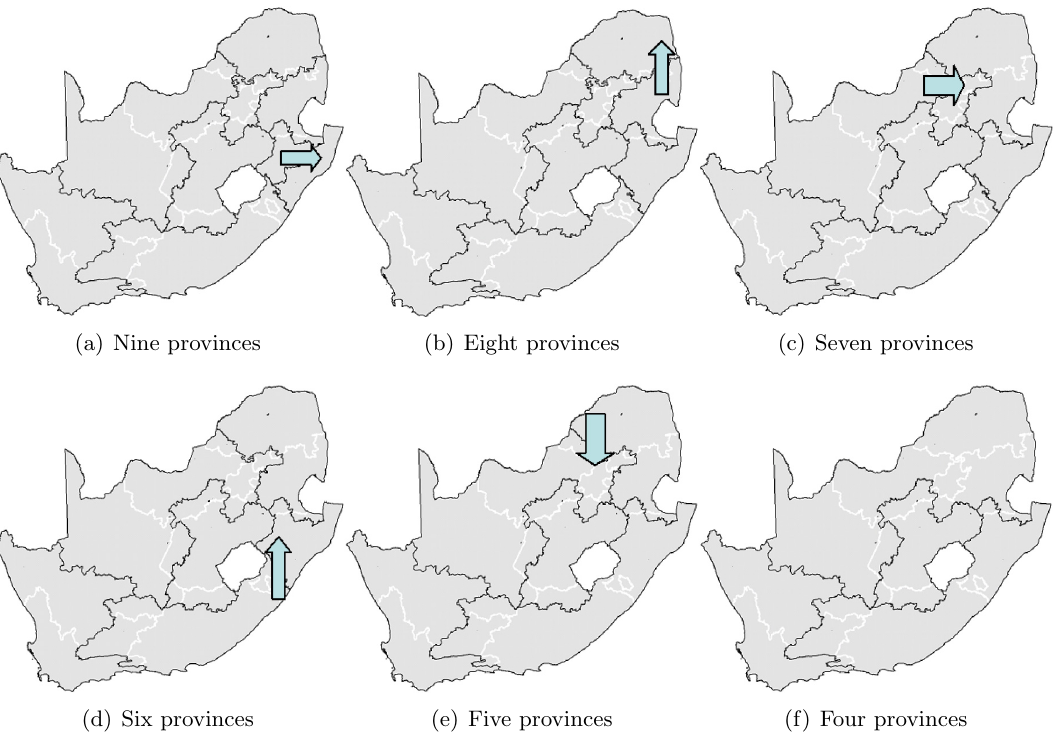
Figure 9: Reduction from nine to four provinces using intramax